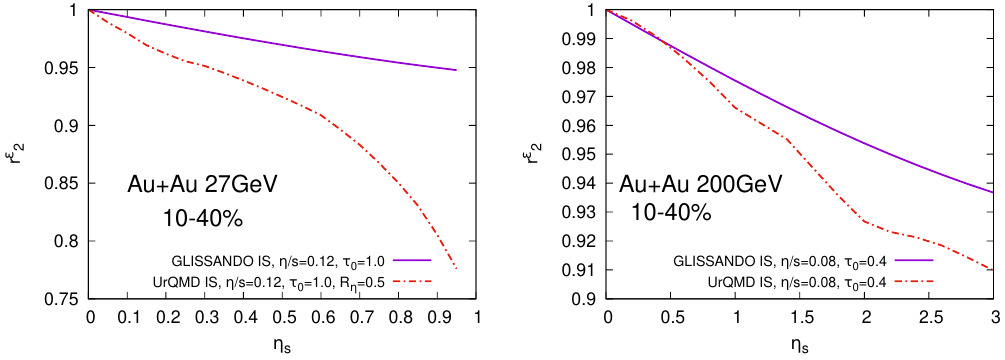
Figure 3: Space-time rapidity dependence of the initial state eccentricity decorrela- tion for 10 − 40% Au-Au collisions at (cid:112) s permission from [ 6 ]